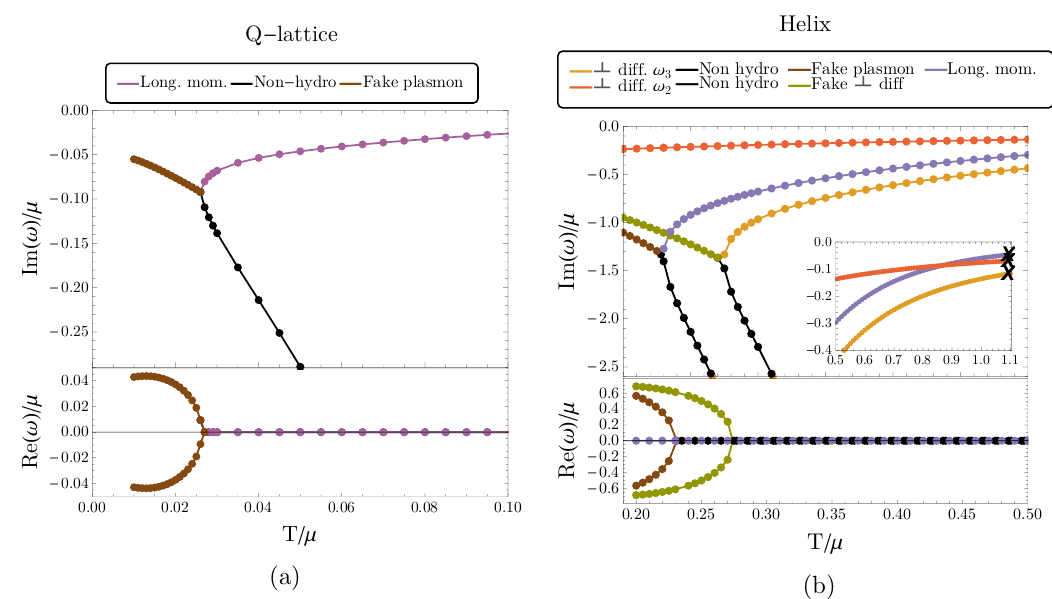
Figure 3. Temperature evolution of the zero wave-vector quasinormal modes. The recombination of the longitudinal momentum dissipation (purple) with the non-hydrodynamic modes (black) is clearly seen in both models. After they collide, they produce a pair of modes with (cid:12)nite real part, even in the long-wavelength limit. These modes are reminiscent of the plasmon. This fake plasmon however appears in the response of the neutral system here. In the helix, we observe two other dissipation modes which correspond to the transverse momentum modes; these are the same modes as in (cid:12)gure 2(b). As temperature decreases, one of them also collides with another non-hydrodynamic mode. The inset shows the crossing of the longitudinal momentum mode and ! 2 ; the black crosses indicate the position of the corresponding modes in (cid:12)gure 2(b).